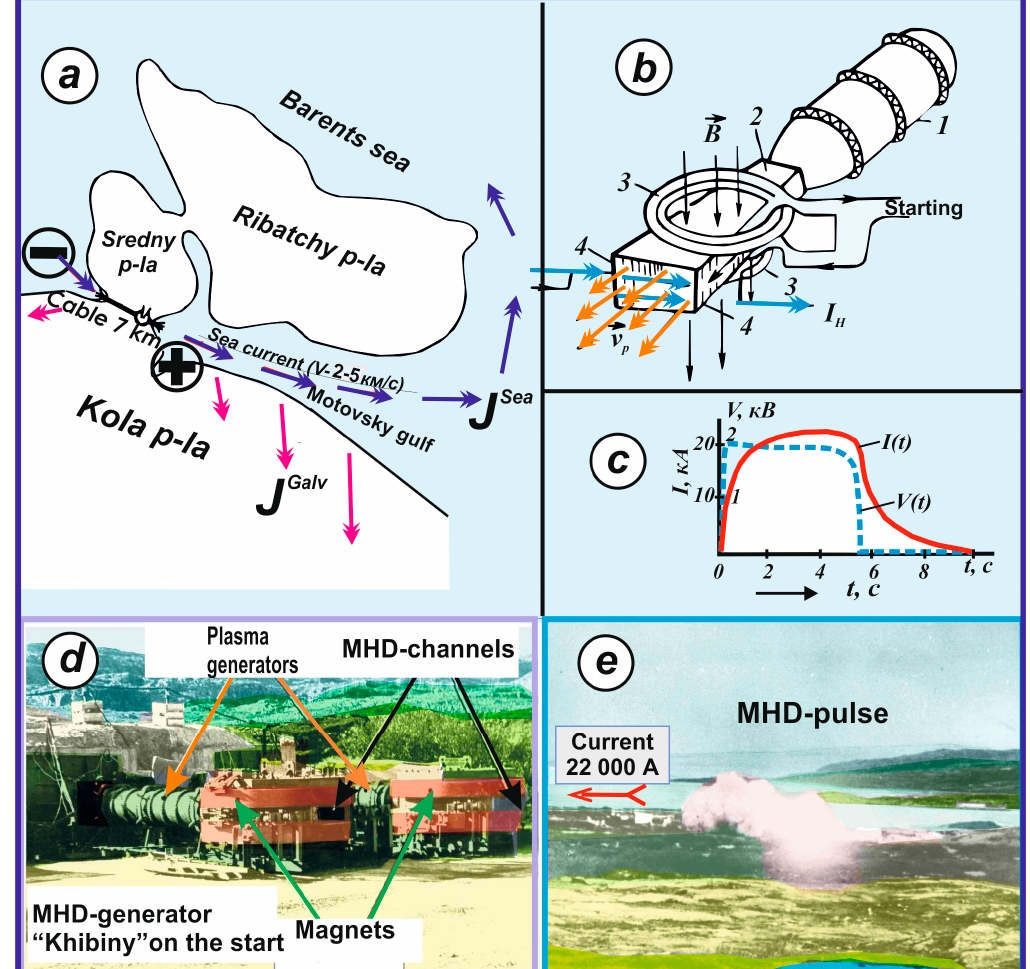
Figure 1. The MHD-installation “Khibiny”. ( a ) Location of 160 ton cable of 7 km length and currents in the sea, J sea and currents in the ground, J galv ; ( b ) principal scheme of pulse MHD-generator “Khibiny”; ( c ) voltage and current intensity in the output of MHD generator “Khibiny”; ( d ) the view of the dual MHD generator “Khibiny”in the working position; ( e ) the gas outbreak that appeared from the MHD pulse producing the current of 22 kA in the Motovsky sea